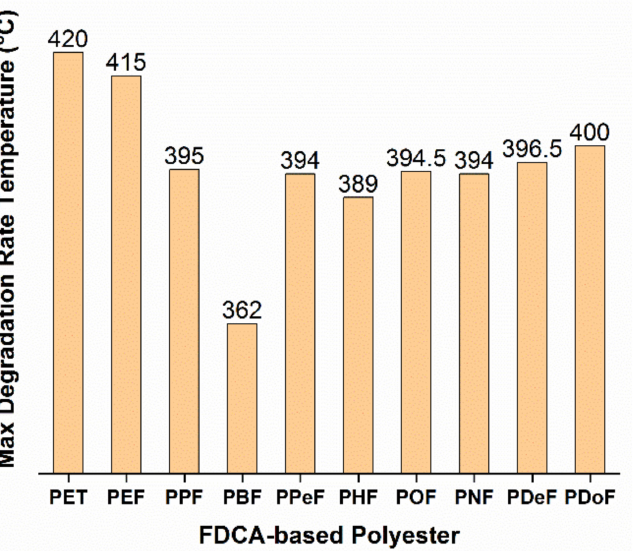
Figure 4. Temperature at which maximum degradation rate is achieved for each polyester (based on data from references